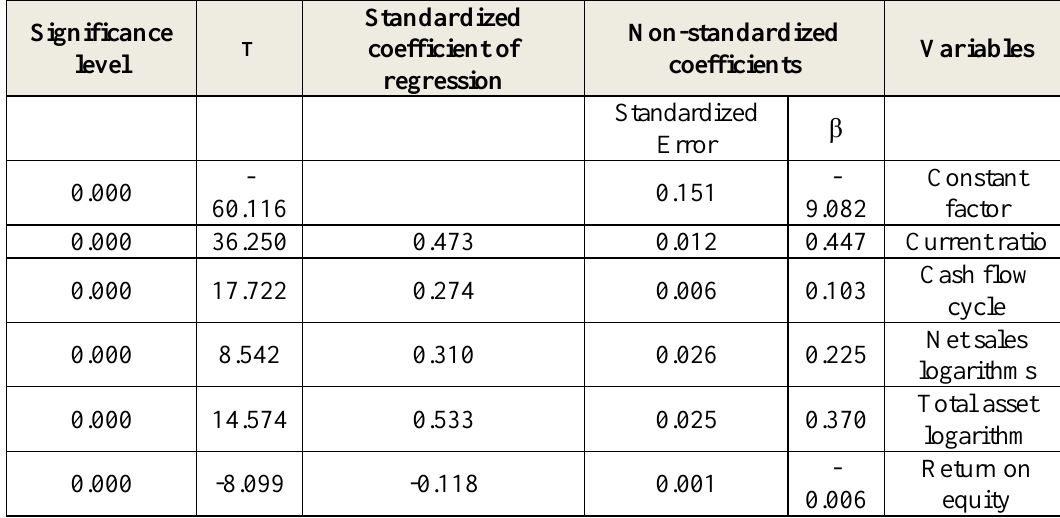
Table 16. Coefficient of regression